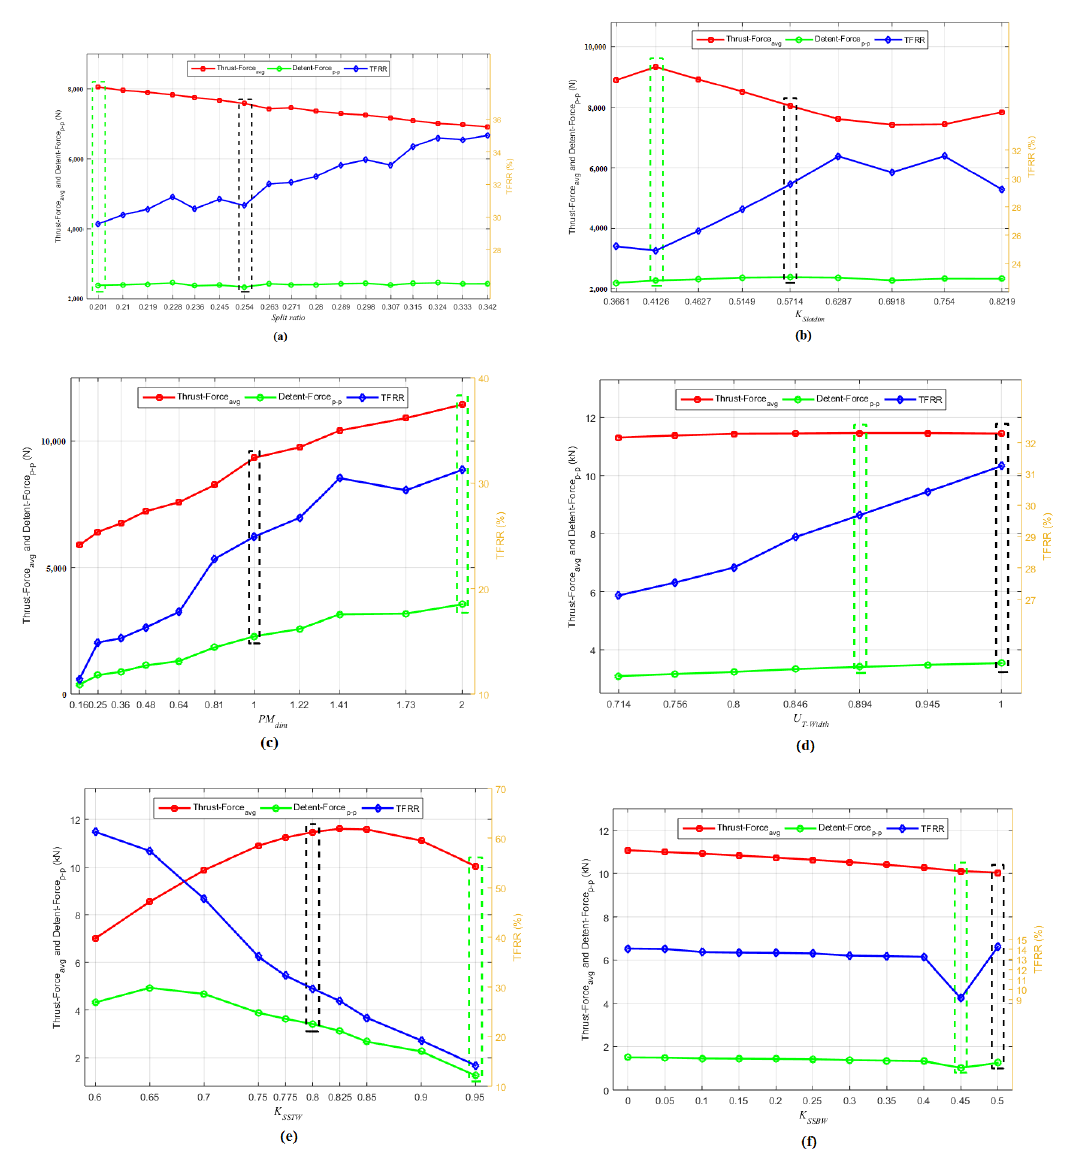
Figure 6. Optimization of HELFSM: (a) split ratio, (b) slot area dimensions, (c) PM dimensions, (d) unequal tooth width, (e) stator segment tip width, and (f) stator segment base width.